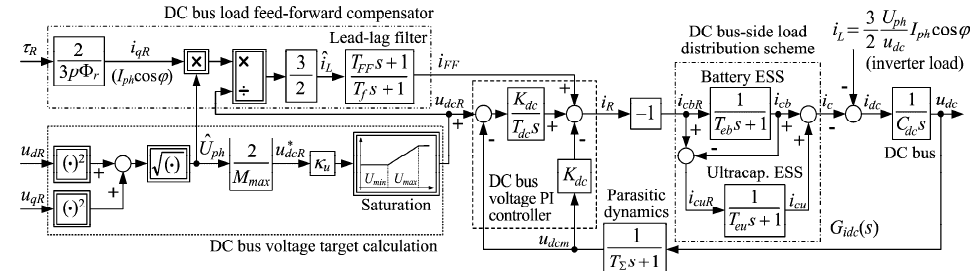
Figure 6. DC bus control system block diagram representation featuring DC bus voltage target calculation from motor phase voltage demand, DC bus load feed-forward compensator and DC bus voltage feedback PI controller commanding the dynamic load distribution